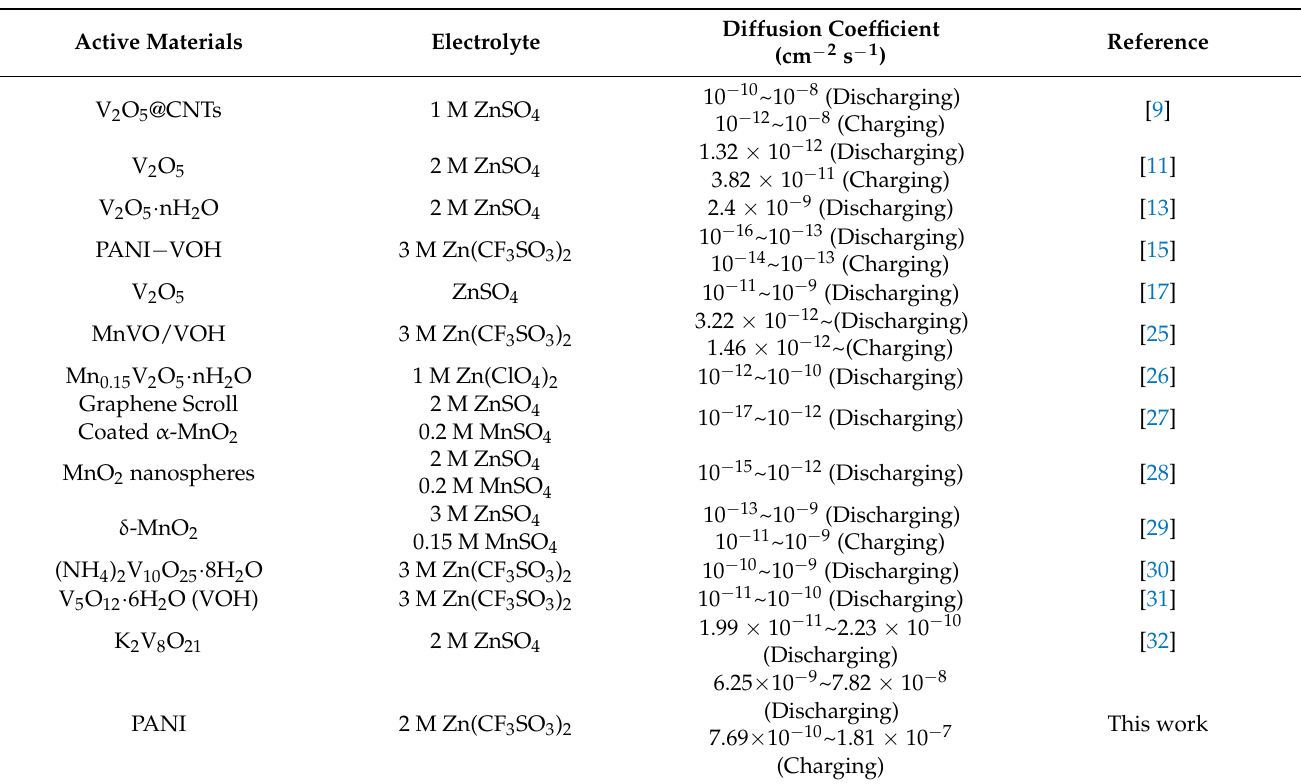
Table 1. Diffusion coefficient of Zn 2+ in referenced cathode